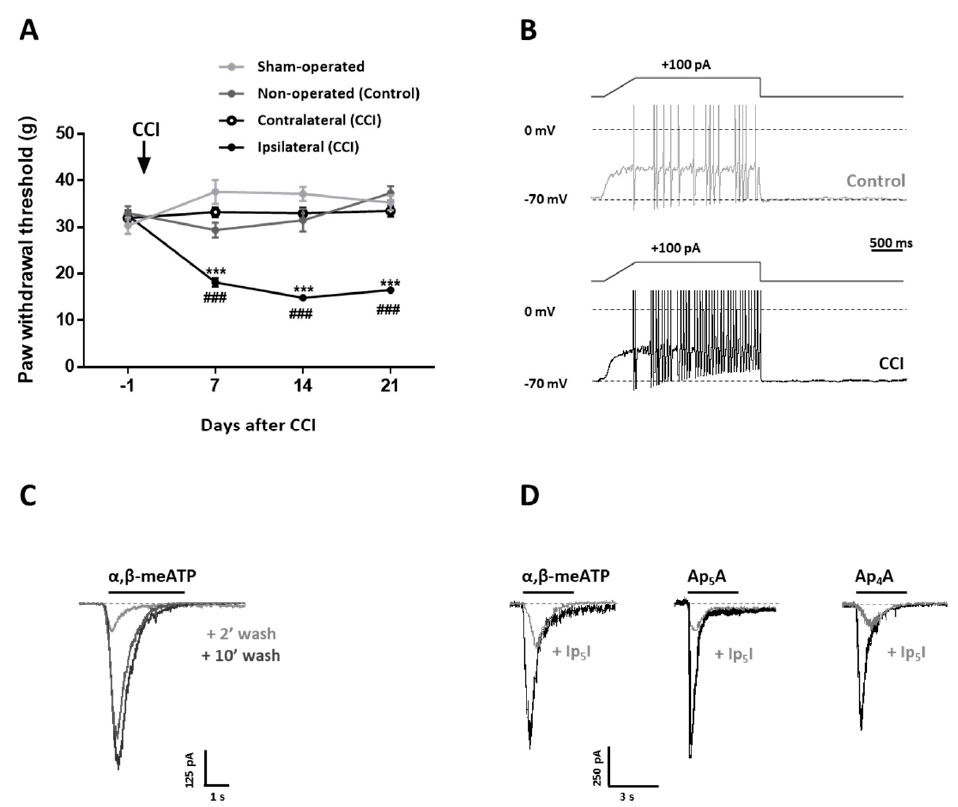
Figure 1. Dorsal root ganglia (DRG) neurons from chronic constriction injury (CCI) animals exhibit increased electrical excitability and P2X3 receptor-mediated currents. ( A ) CCI animals develop mechanical allodynia. Data show paw withdrawal thresholds to mechanical stimulation of the hindpaw’s plantar surface in the ipsilateral and contralateral paws from CCI animals ( n = 16 rats), ipsilateral paw from sham-operated ( n = 9 rats) animals, and both paws from non-operated (Control; n = 11 rats) animals. Behavioral testing was performed 1 day before ( − 1), 7, 14 and 21 days after CCI surgery. Statistical analysis was performed by a two-way ANOVA for repeated measures followed by a Bonferroni test to compare responses obtained at the same times (***, p < 0.001). Statistical significance of the effect of CCI with respect to baseline ( − 1) was assessed by a Student t test for paired data. ( ### , p < 0.001). ( B ) Current-clamp recordings of action potentials evoked by current injection in DRG neurons from control (non-operated) and CCI animals. Current protocol is shown at the top of the panel. V comm = − 70 mV. Results are representative of those obtained in 3 cells from Control or CCI animals, respectively. ( C ) Voltage-clamp recordings of currents evoked by α , β -methylene ATP ( α , β -meATP) in DRG neurons. The horizontal bar shows the application of α , β -meATP (10 µ M, 3 s), which was applied three times with 2 (+2’ wash) and 10 (+10’ wash) min intervals. Currents rapidly decayed in the presence of the agonist and required a minimum of 10 min washout for complete recovery from desensitization. ( D ) Sensitivity to diinosine pentaphosphate (Ip 5 I) of currents evoked by α , β -meATP, Ap 5 A or Ap 4 A in DRG neurons from Control animals. Horizontal bars show application of α , β -meATP (10 µ M, 3 s), and the diadenosine polyphosphates, Ap 5 A (10 µ M, 3 s) or Ap 4 A (10 µ M, 3 s), which were applied twice each, at 10 min intervals in the absence or the presence of Ip 5 I (+Ip 5 I; 10 µ M, 2 min). Results are representative of those obtained in 6, 8 and 8 cells with α , β -meATP, Ap 5 A or Ap 4 A, respectively.